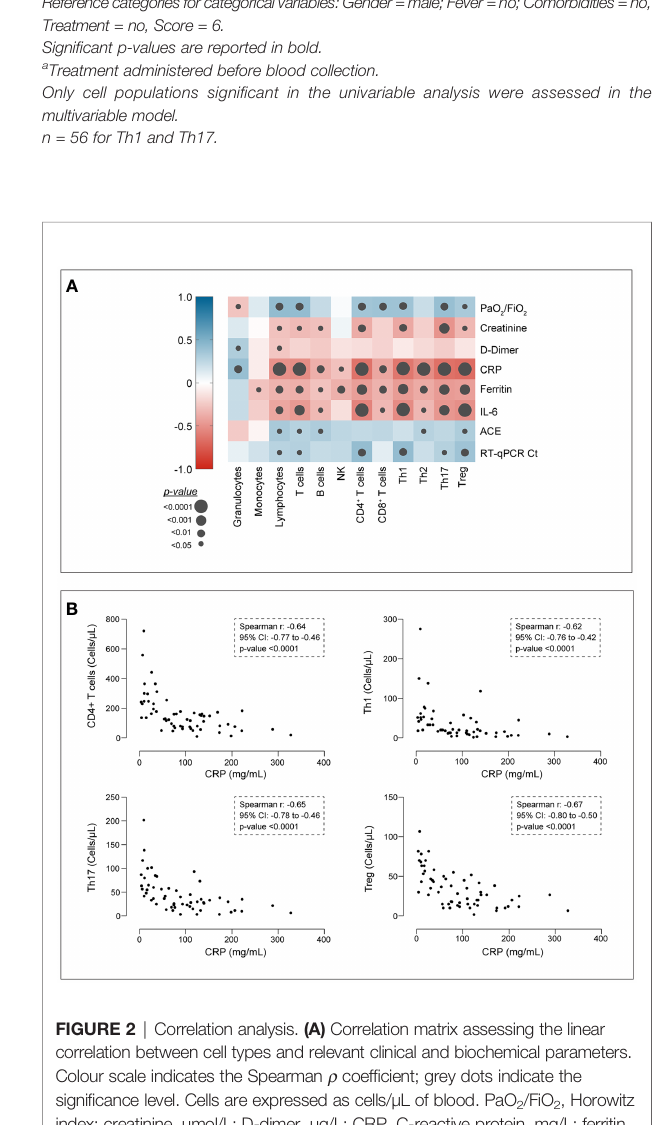
FIGURE 2 | Correlation analysis. (A) Correlation matrix assessing the linear correlation between cell types and relevant clinical and biochemical parameters. Colour scale indicates the Spearman r coef fi cient; grey dots indicate the signi fi cance level. Cells are expressed as cells/µL of blood. PaO 2 /FiO 2 , Horowitz index; creatinine, µmol/L; D-dimer, µg/L; CRP, C-reactive protein, mg/L; ferritin, µg/L; IL-6, interleukin-6 measured at the time of complete blood count, pg/mL (chemiluminescence immunoassay); ACE, angiotensin converting enzyme (U/L); RT-qPCR Ct, number of cycles. (B) Detailed scatter plots of correlations displaying Spearman r coef fi cient >